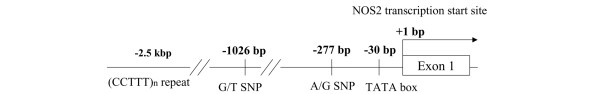
Polymorphisms of the 5' flanking region of the human NOS2 gene. TATA sequence begins at position -30 bp from the transcription start site of exon 1. bp, base pairs; SNP, single nucleotide polymorphism.